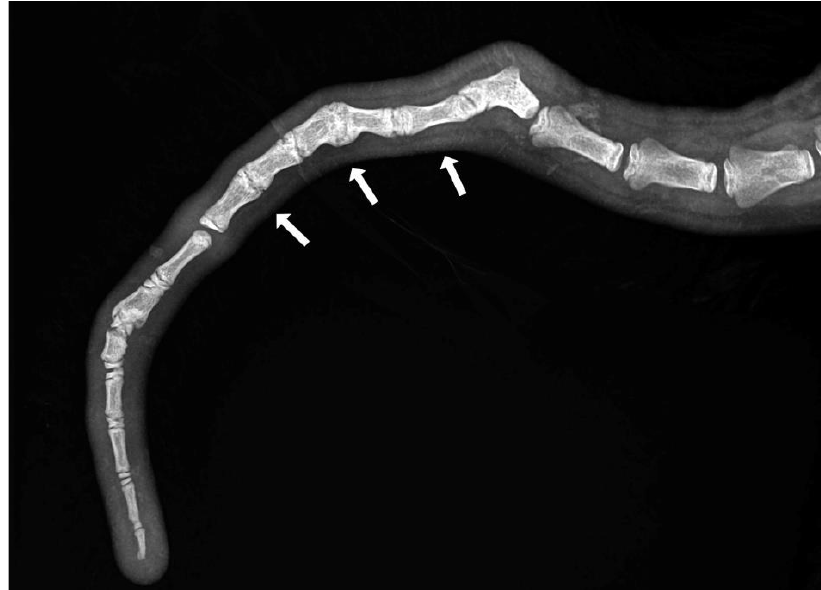
Figure 2. Section of an X-ray of a lamb’s tail with multiple block vertebrae.